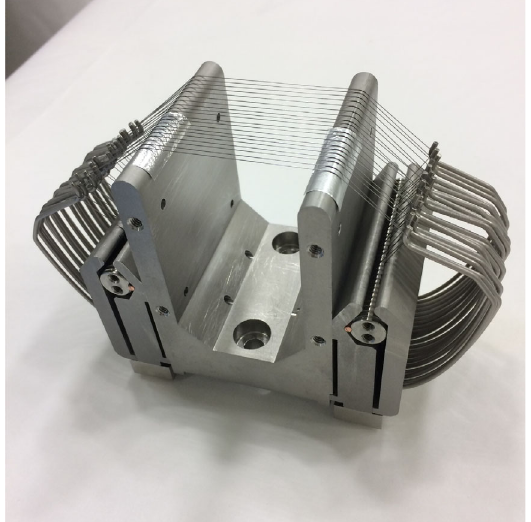
FIG. 9. SPS diffuser wire array, comprising 20 Ta wires of ∅ 200 μ m individually tensioned with springs and aligned in two sections with a 60 μ m offset. The wires are spaced by 1.5 mm for a total array length of 30 mm.